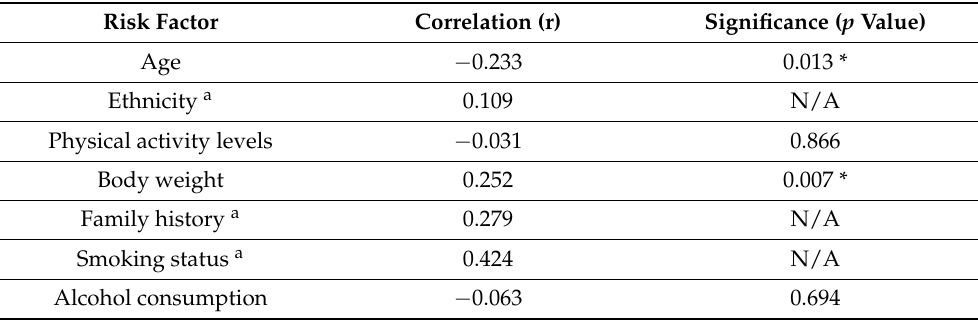
participants at